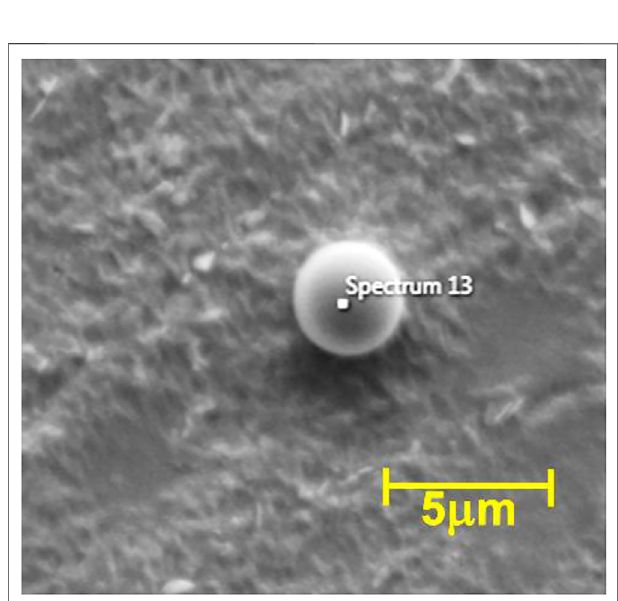
FIGURE11| Micrographofdeep-etchedsampletaken13 minutesafter Ca treatment in experiment A, showing the absence of small inclusions.